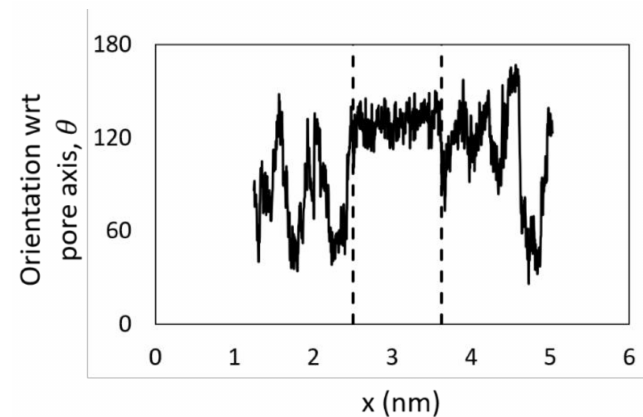
Figure 11. Orientation of the [V(H 2 O) 6 ] 2+ complex with respect to the pore axis during membrane transport in BEC zeolite membrane. The dashed lines indicate the zeolite boundary. Tumbling, followed by alignment and finally tumbling are